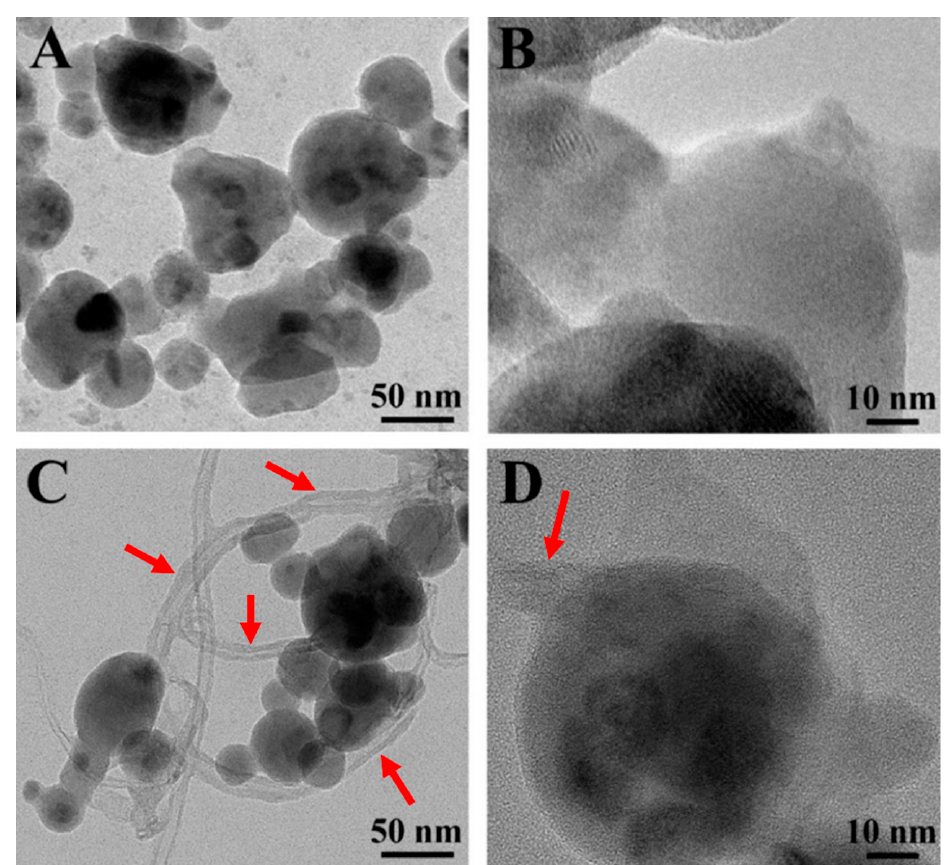
Figure 2. TEM images for ( A , B ) CuFe 2 O 4 and ( C , D ) CFO-20. Arrows show MCNTs. The choice of dispersants plays a crucial role in the nanotechnology of composites. It is important to find a dispersant suitable for the dispersion of both CuFe 2 O 4 particles and MC- NTs. The dispersant must be strongly adsorbed on CuFe 2 O 4 particles and MCNT, because non-adsorbed dispersant can promote agglomeration. Therefore, CuFe 2 O 4 particles and MCNTs must be co-dispersed using a co-dispersant. The anchoring groups of dispersants play a vital role in their adsorption on inorganic particles. Recent studies [38] have shown that monodentate bonding provides relatively weak adsorption and new types of disper- sants have been developed with bidentate chelating or bridging bonding. Such dispersants showed superior adsorption and facilitated the development of advanced nanocomposites and film deposition technologies [38]. These studies highlighted the advantages of charged dispersants containing chelating anchoring groups which facilitated dispersant adsorption by creating complexes with metal atoms on the particle surface [38–40]. Moreover, it was found that redox-active dispersants containing chelating groups could facilitate charge transfer between oxide particles and conductive additives or current collectors and increase pseudocapacitance [41]. In this investigation, we examined properties of ASPA molecules for the co-dispersion of CuFe 2 O 4 particles and MCNTs. It is known that ASPA exhibits redox-active properties [42] in a negative potential range and forms complexes with Cu, Fe, Ni, Zn, Co and other metals [43]. The complex formation involved a tridentate bonding [44]. It was suggested that similar complexes (Figure 3) can be formed with Cu and Fe atoms on the surface of CuFe 2 O 4 particles. It was found that the adsorbed negatively charged ASPA molecules allowed for electrostatic particle repulsion and the improved suspension stability of CuFe 2 O 4 particles. Moreover, a good suspension stability of MCNTs was achieved in the presence of ASPA. It is suggested that ASPA adsorption on MCNTs involved hydrophobic interactions of the side walls of the MCNTs with barbiturate-like rings [44] of the ASPA molecules. The electrostatic co-dispersion of the CuFe 2 O 4 particles and MCNTs